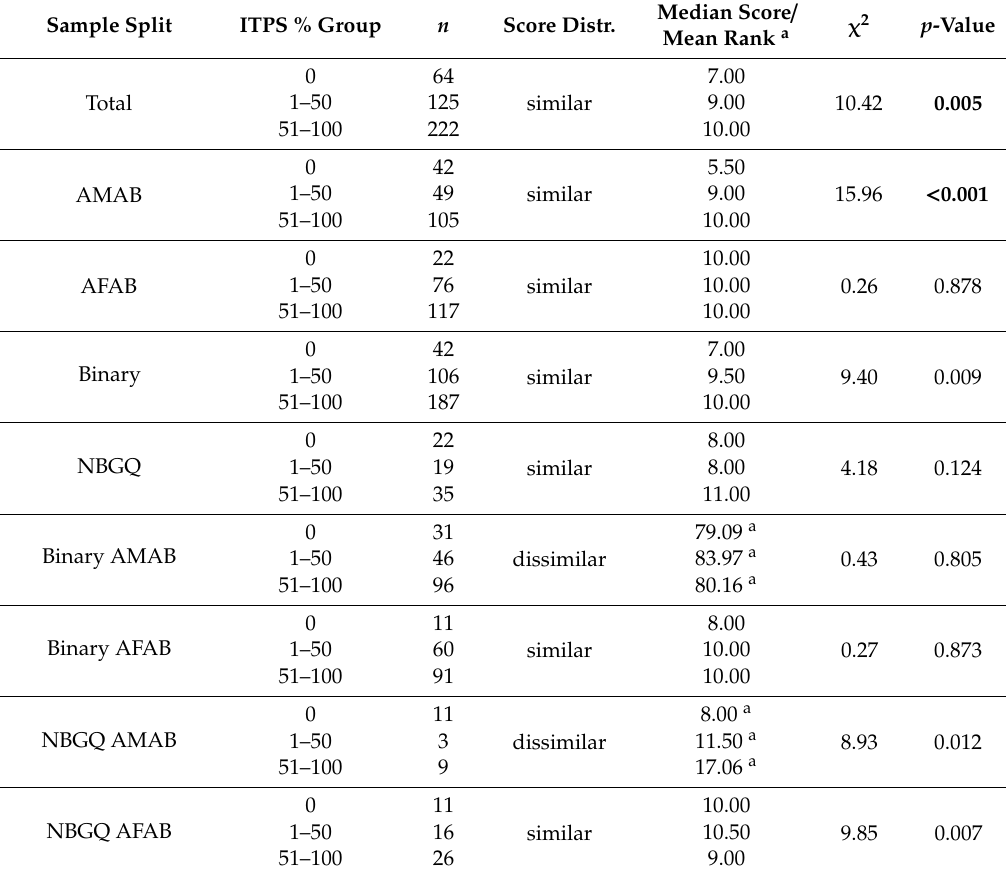
Table 1. Results of the Kruskal–Wallis H tests for the variable ‘desire to participate in decision-making’. Sample Split ITPS % Group n Score